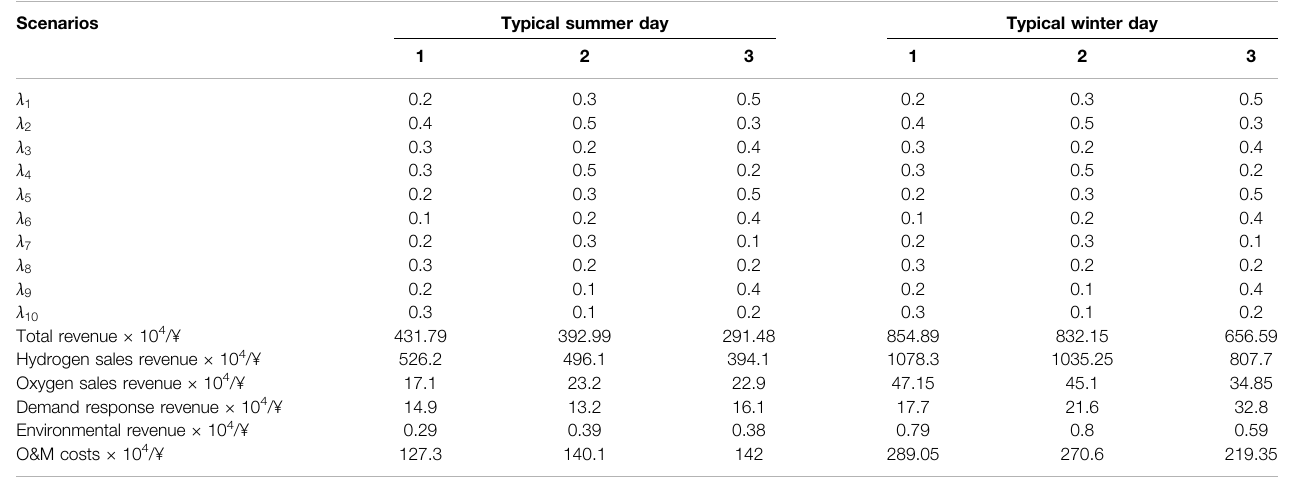
TABLE 4 | Optimal revenue of different weight coef fi cients. Scenarios Typical summer